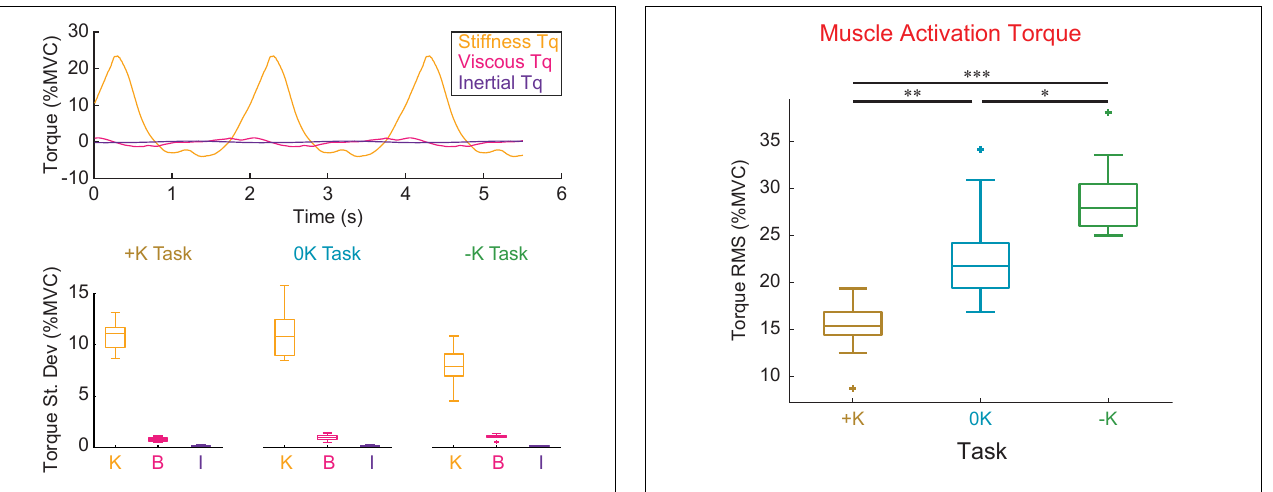
than the torque due to viscosity ( + K: 0.79 ± 0.14% MVC; 0K: 0.96 ± 0.20% MVC; –K: 1.06 ± 0.16% MVC) and two orders of